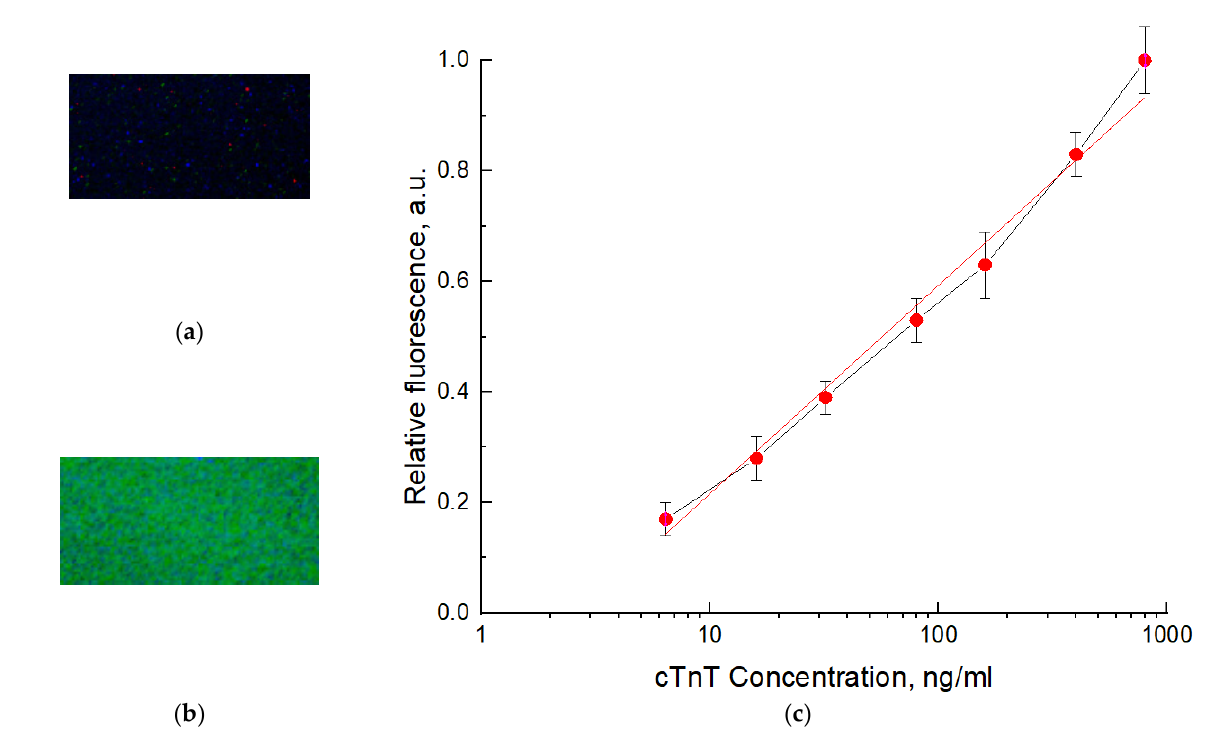
Figure 7. Images of the fragment of the biosensor working chamber filled with 800 ng/mL of troponin T solution recorded directly via glass window ( a ) and deposited onto the glass luminophore layer ( b ); relationship of relative fluorescence intensity versus concentration of cardiac troponin T for chips with the luminophore layer ( c ), where for curve, the red line indicates the linear approximation for the selected area.